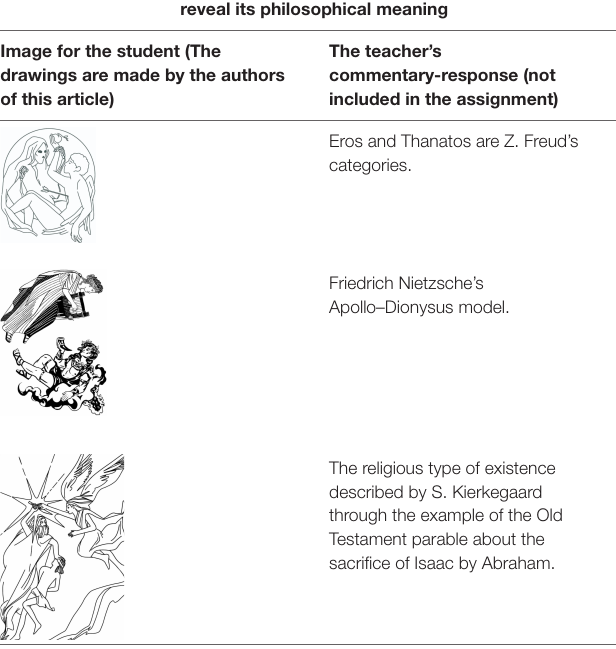
TABLE 2 | Fragment of practical